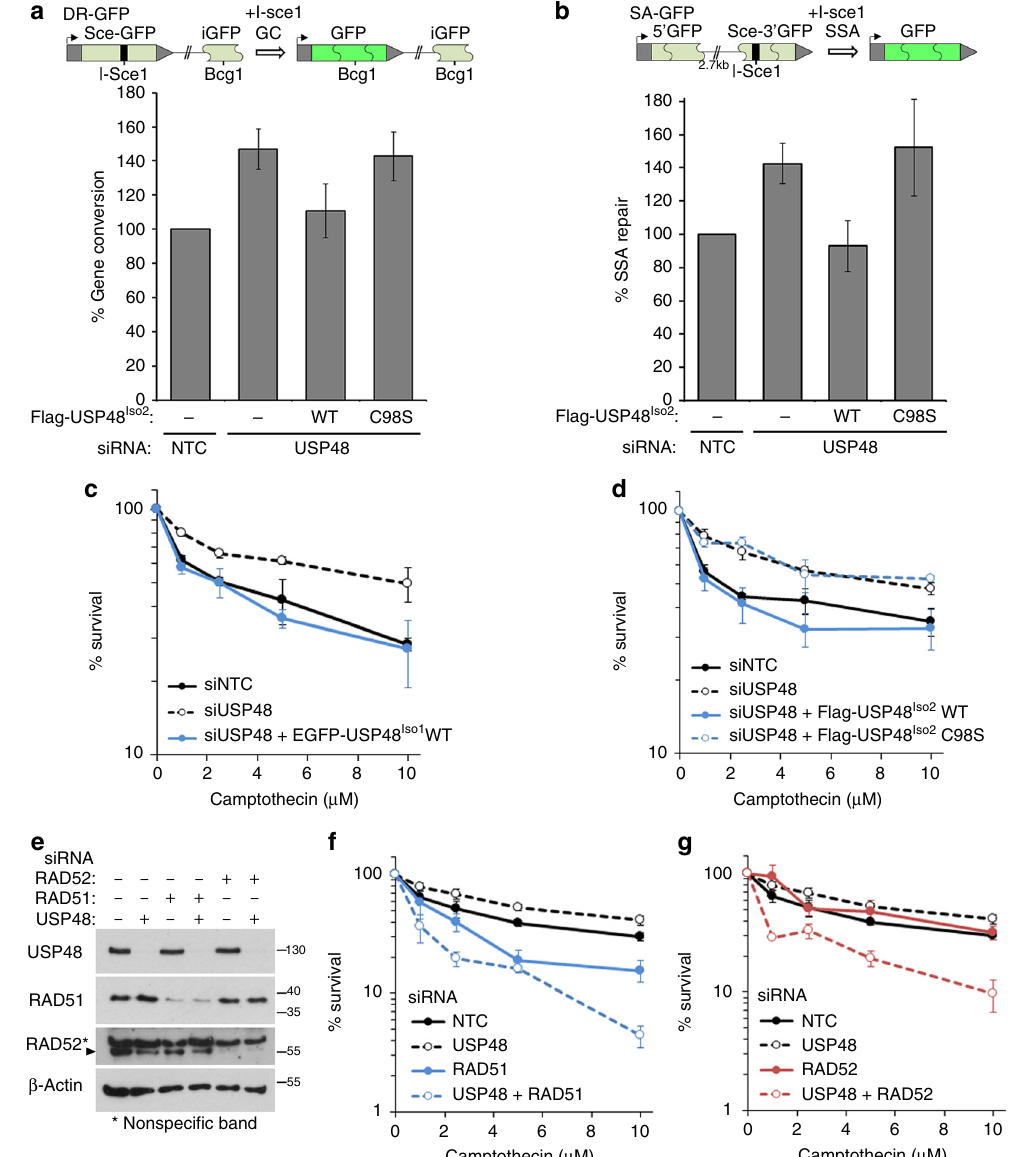
Fig. 5 USP48 restrains homology-directed repair mechanisms. a Gene conversion (GC) was measured using U20S DR3-GFP reporter cells as illustrated. It is noteworthy that the functional GFP cannot be produced by SSA from this substrate as the template iGFP lacks the 5 ′ - and 3 ′ -regions of GFP 38 . Cells depleted for USP48 were transfected with RFP, I-Sce1 , and either Flag-USP48 Iso2 -WT or Flag-USP48 Iso2 -C98S. GFP-positive cells were normalized to RFP- transfection ef fi ciency. %-repair is given compared with NTC. Graph shows mean, n = 5, error bars are SEM. b Single-strand annealing (SSA) was measured using U20S SA-GFP reporter cells as illustrated. The two GFP fragments of the substrate share 266 nucleotides of homology. In principle GC with crossing over could also produce functional GFP; however, these have been shown to be rare events 39 . Cells were treated and analysed as in a . Graph shows mean, n = 3, error bars are SEM. c , d Camptothecin colony survival curves of HeLa cells depleted for USP48 and complemented with EGFP- USP48 Iso1 -WT, n = 3 c or Flag-USP48 Iso2 -WT or Flag-USP48 Iso2 -C98S, n = 4 d . Graph shows mean % survival normalized to untreated controls, error bars are SEM. e Western blottings to demonstrate USP48, RAD51, and RAD52 protein expression levels in HeLa cells following siRNA as indicated. f , g Camptothecin colony survival curves of HeLa cells depleted for USP48, RAD51, and both USP48 and RAD51 f , and USP48 and RAD52 alone or together g . Graph shows mean % survival normalized to untreated controls, n = 3, error bars are